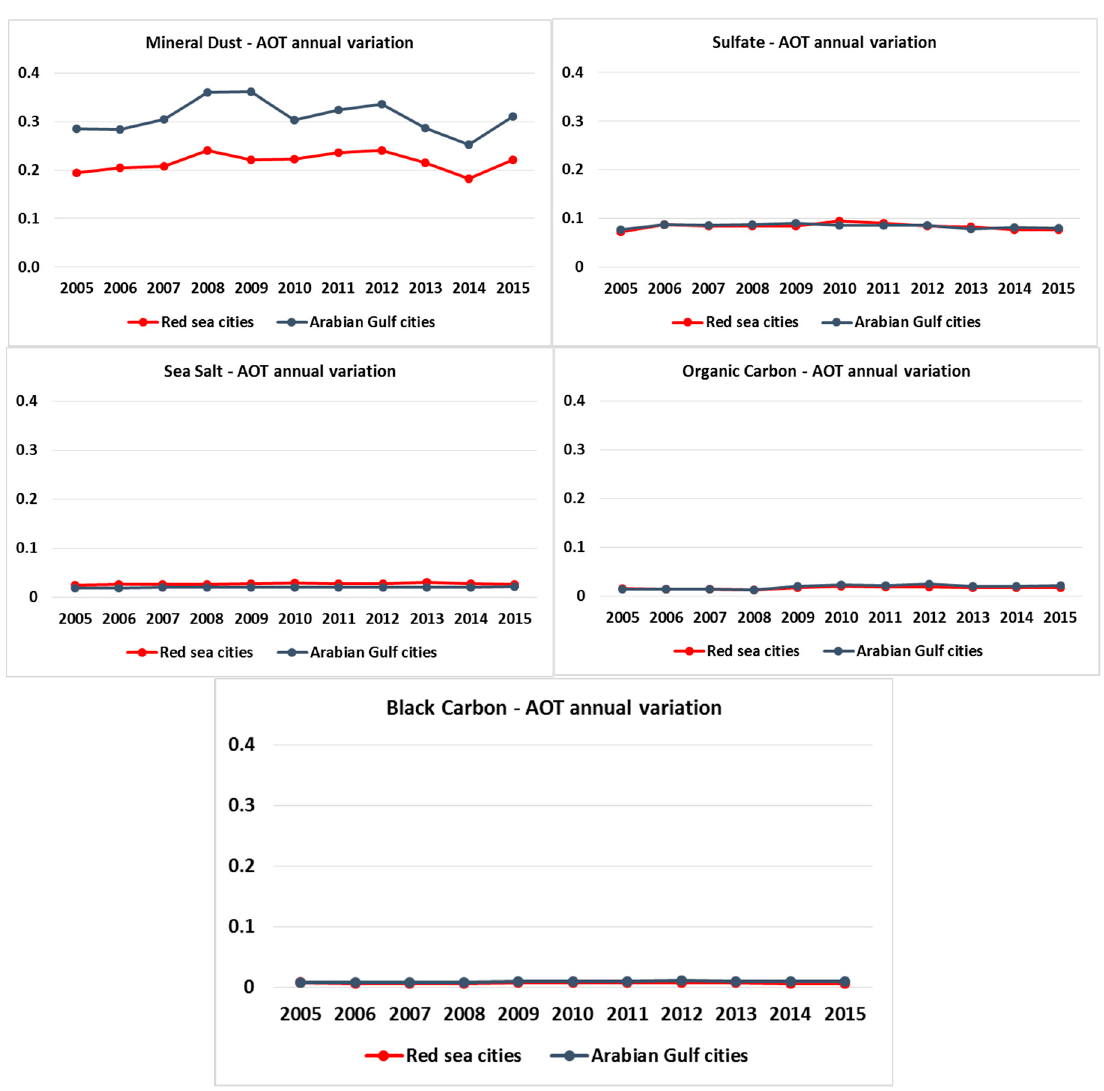
Figure 6. Annual variation in aerosol AOT over the Arabian Peninsula cities—cities on the Red Sea vs. cities on the Arabian Gulf.